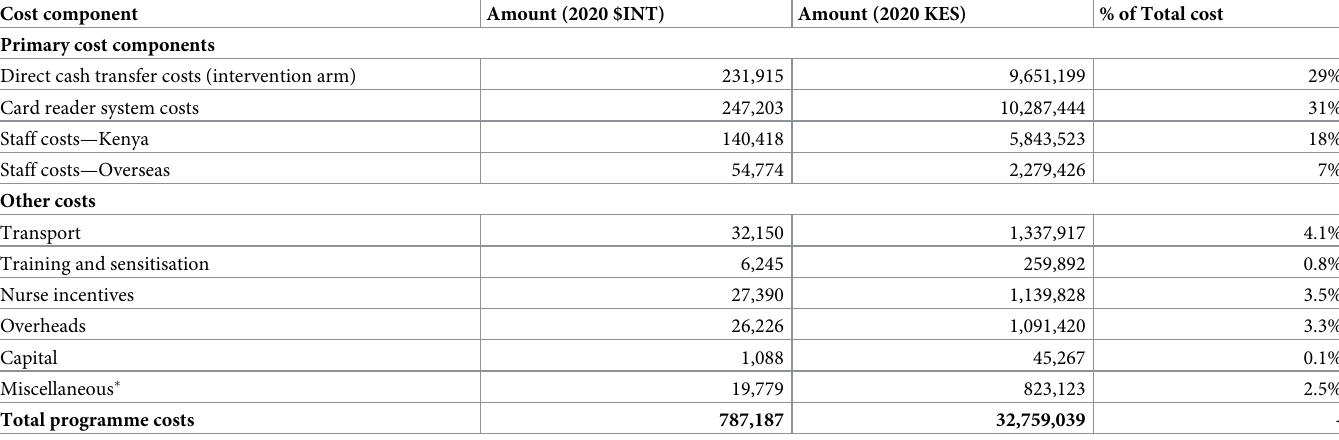
Table 1. Afya programme costs by component.